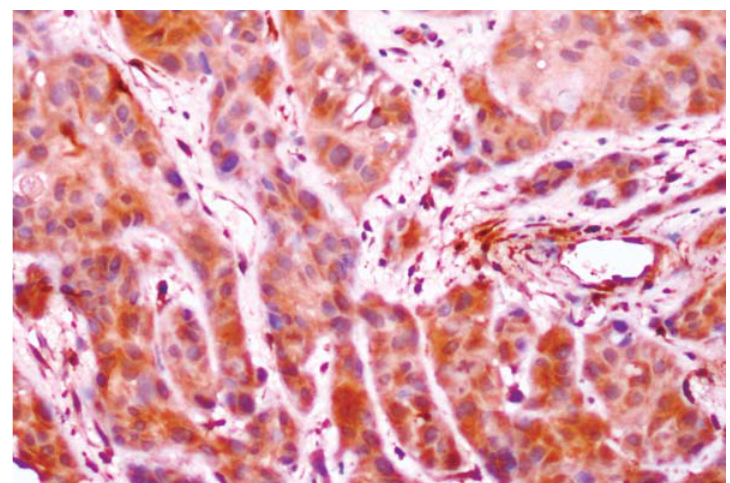
Figure 2- Oral squamous cell carcinoma (OSCC) showing type 2 cord like pattern of invasion (S100 A4, 20x)